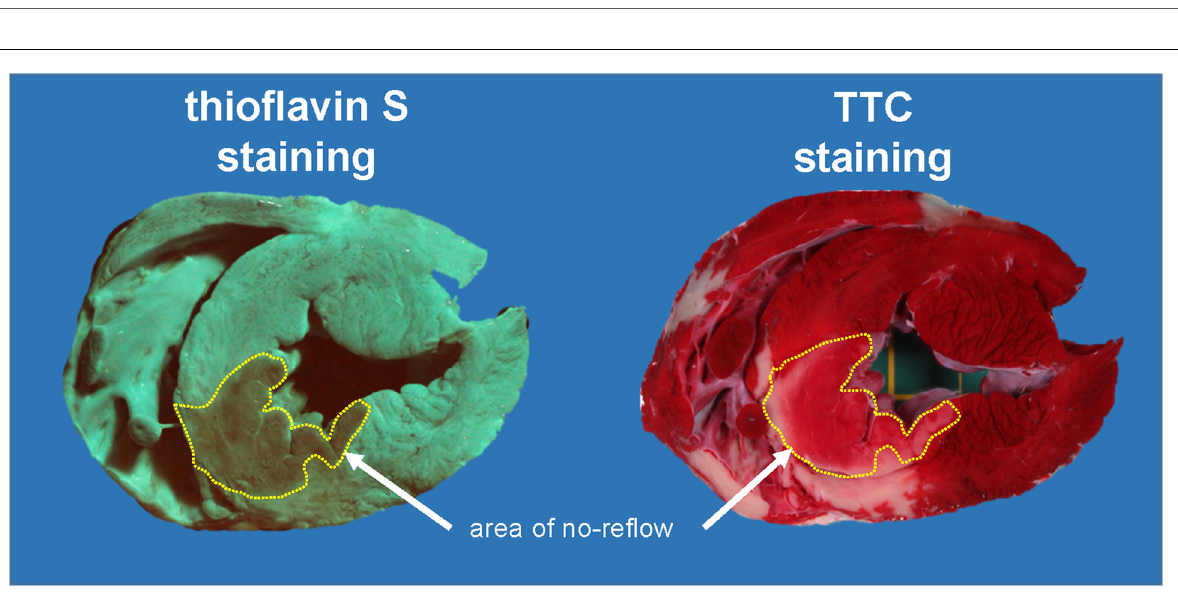
FIGURE 2 Area of no-re fl ow following ischaemia/reperfusion without and with diazoxide pretreatment or diazoxide before reperfusion, respectively; individual data (circles) and means (squares) with SD; mean±SD are also given as numerical data for ischaemia/reperfusion ( n =5), pretreatment with diazoxide+ ischaemia/reperfusion ( n =5), and diazoxide before reperfusion ( n =4). The asterisk in the scatter plot of data diazoxide before reperfusion indicates a pig with persistent TTC-positive staining within an area of no-re fl ow, as indicated by the negative thio fl avin-S staining. Data were analysed by one- way analysis of variance and LSD post-hoc test s. LSD, least square difference; TTC, triphenyl tetrazolium chloride.